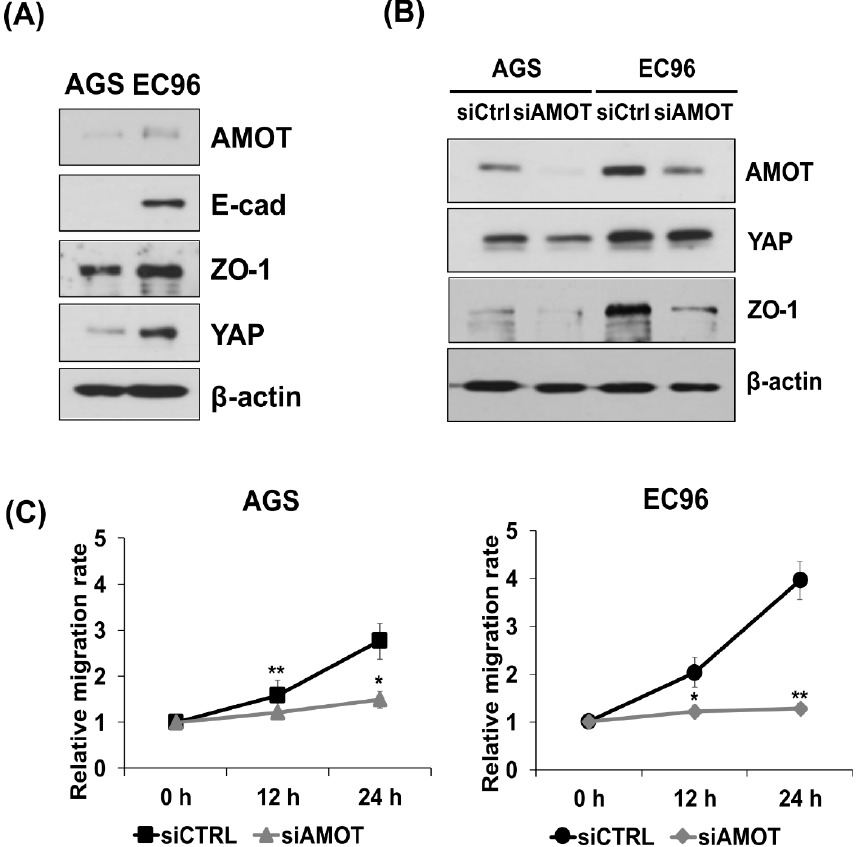
Figure 4. AMOT mediates the linkage between YAP and ZO ‐ 1. ( A ) AGS and EC96 cells were sub ‐ jected to immunoblot analysis using the indicated antibodies. ( B , C ) AGS and EC96 cells transfected with siAMOT RNA were subjected to immunoblot analysis using the indicated antibodies ( B ) and cell migration assay ( C ). * p < 0.05 and ** p < 0.01 in ( C ).